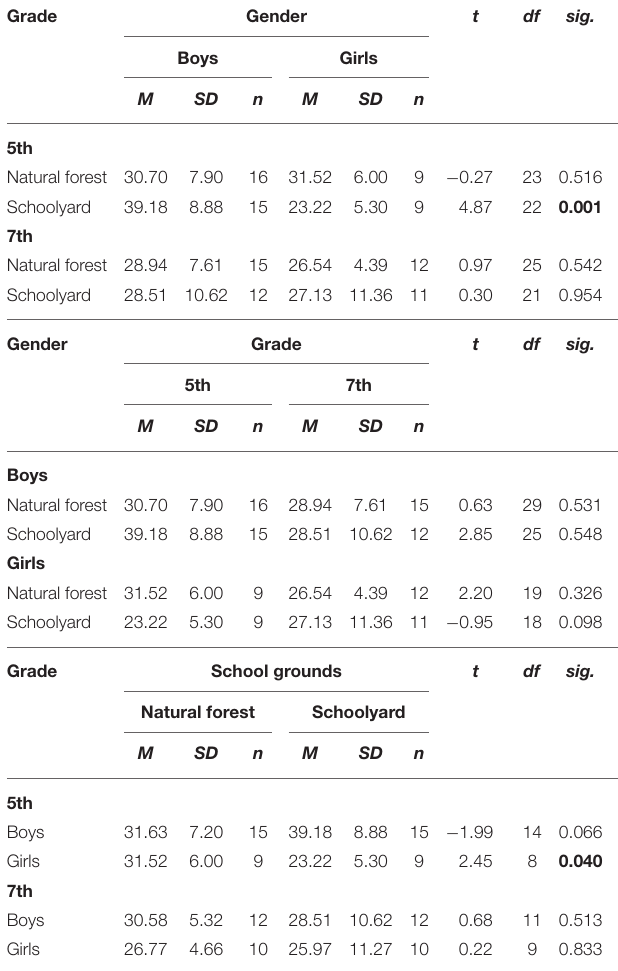
TABLE 1 | Time spent (in min) in moderate-to-vigorous physical activity (MVPA) among school children in the natural forest and constructed schoolyard: a series of t -test